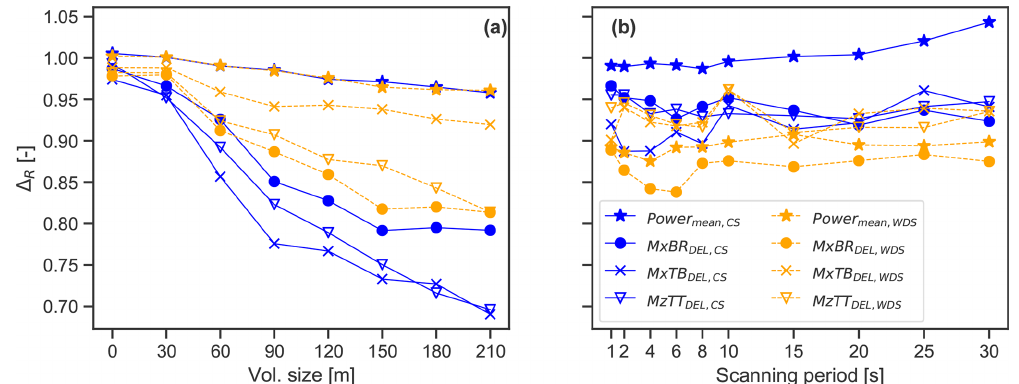
Figure 17. Influence of lidar scanning specifications on the lidar-based load prediction accuracy, including (a) the effect of probe volume size given U amb = 6ms − 1 and TI amb = 8% and (b) the effect of the scanning period given U amb = 6ms − 1 and TI amb = 16%. The bias (cid:49) R at each nominal value is computed from 18 simulated field realizations. The Grid pattern is used for the analysis.